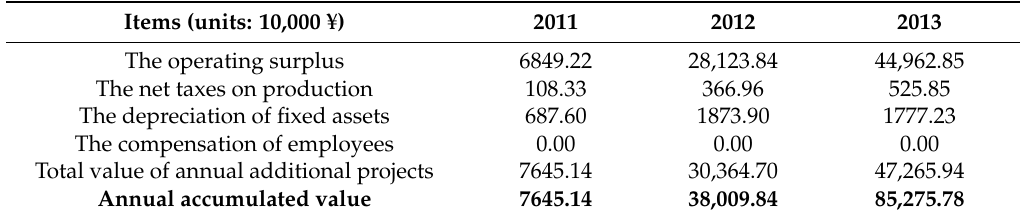
Table 3. The output appreciation generated by annual new ECER projects of the Air Transportation Industry from 2011 to